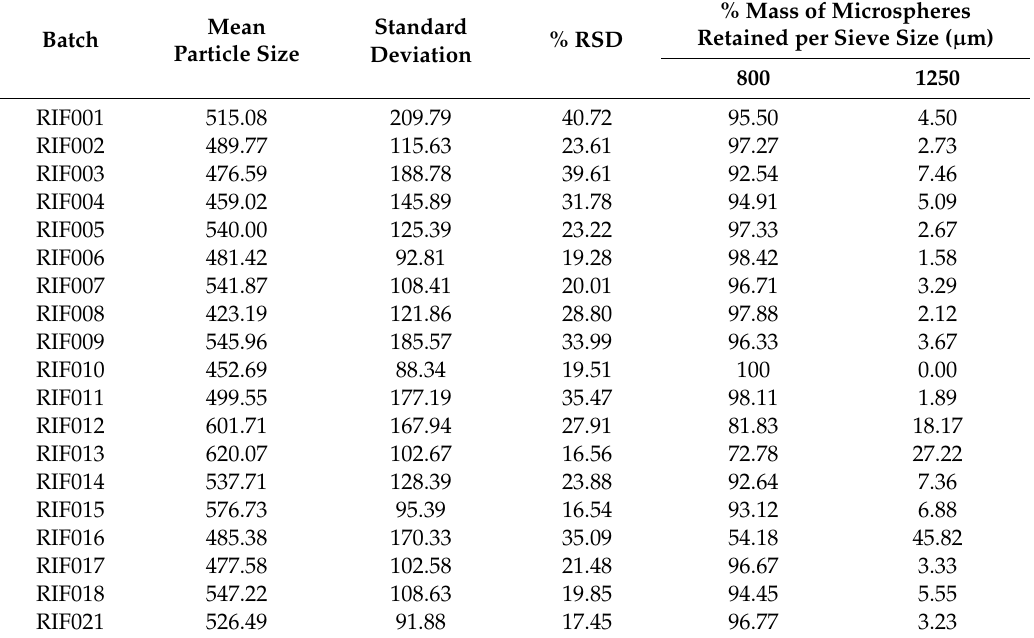
Table 13. Mean particle size and size distribution of RIF microspheres for BBD, optimized, and modified